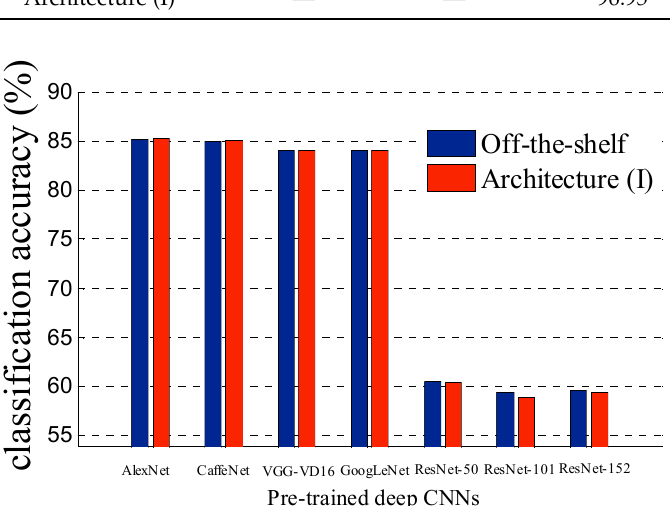
Figure 15. Accuracy of remote scene classification on Brazilian Coffee Scenes dataset.